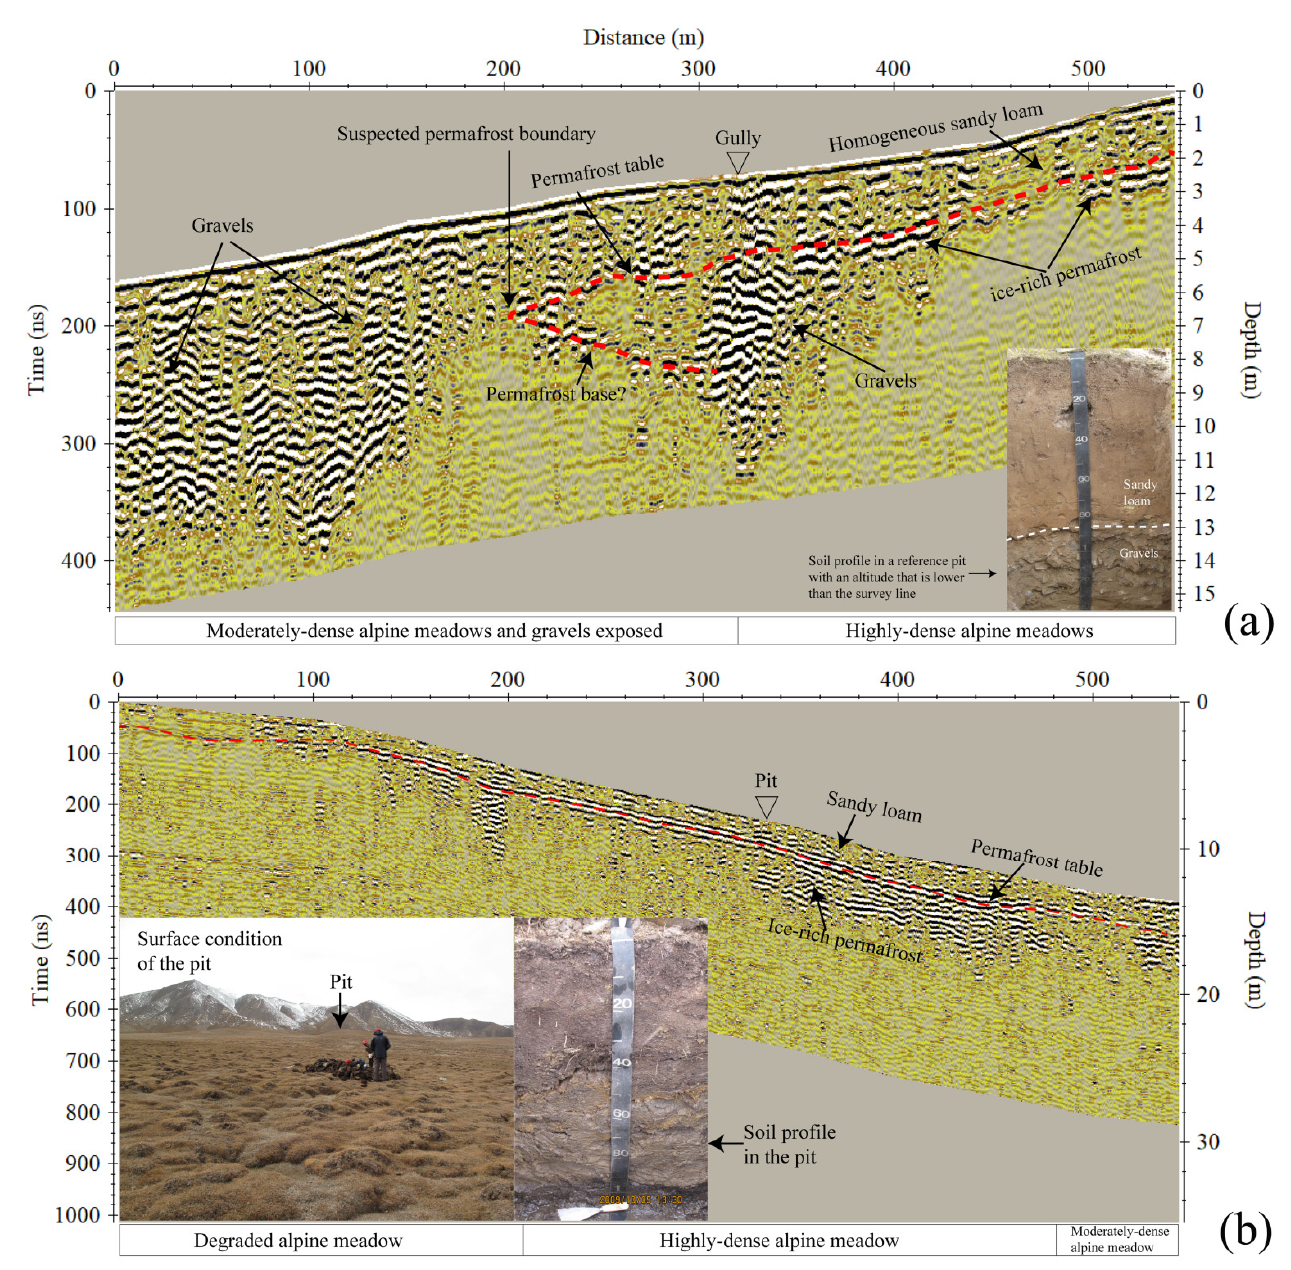
Figure 5. The interpretation of two ground-penetrating radar (GPR) profiles in the same geo- morphic unit. ( a ) P057 (altitude: 4125–4182 m), ( b ) P052 (altitude: 4264–4351 m). The first section (0–200 m)